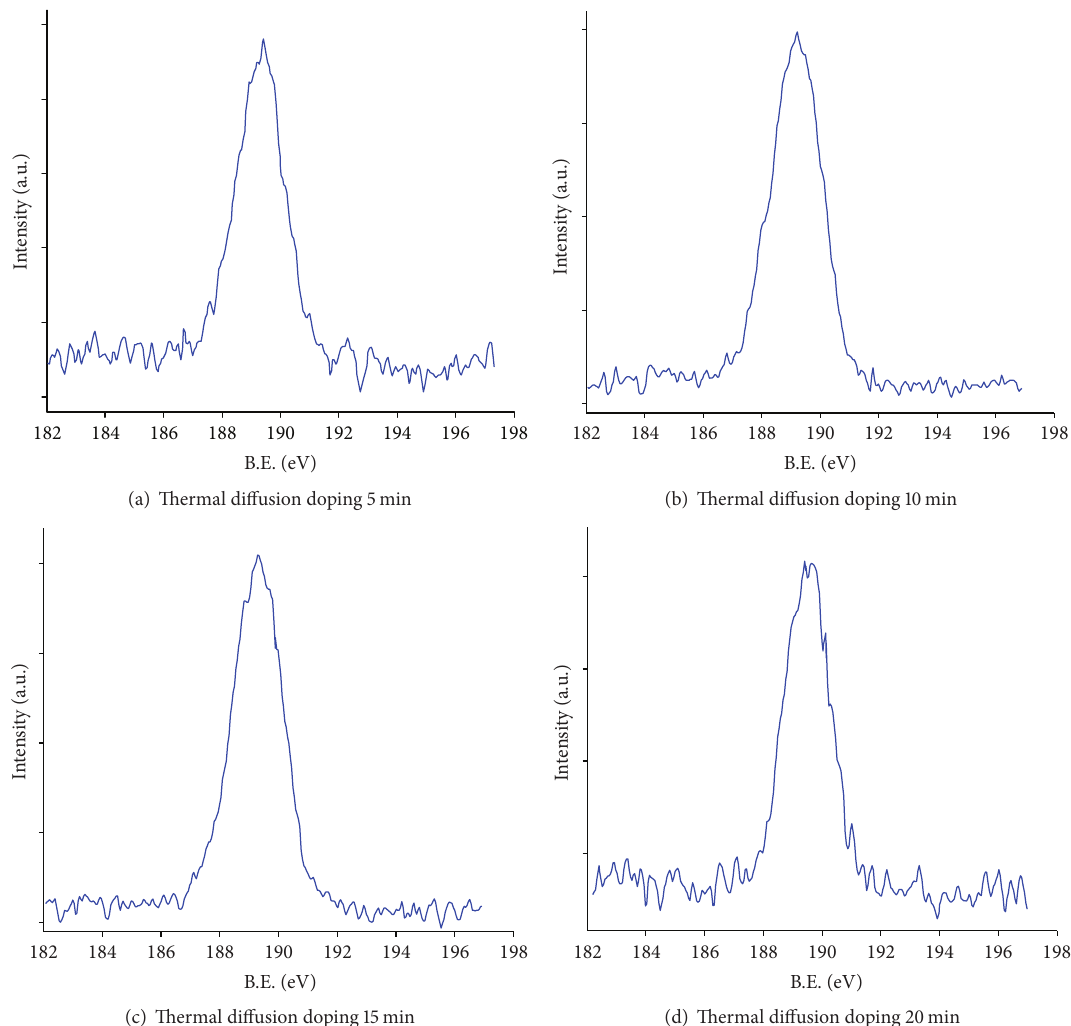
Figure 1: Fitting curve of B1s core level spectrogram of ta-C:B film with different thermal diffusion